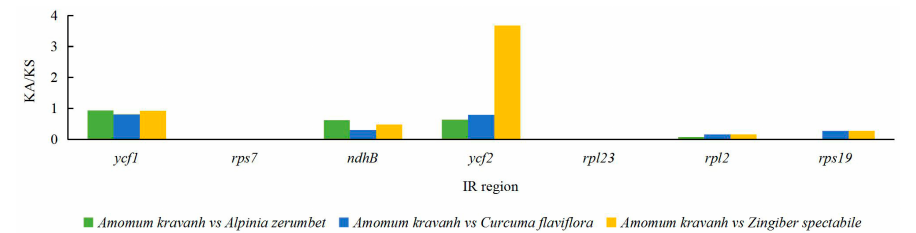
Figure 5. Ka/Ks values of 80 protein-coding genes of A. kravanh , A. zerumbet , C. flaviflora and Z. spectabile .